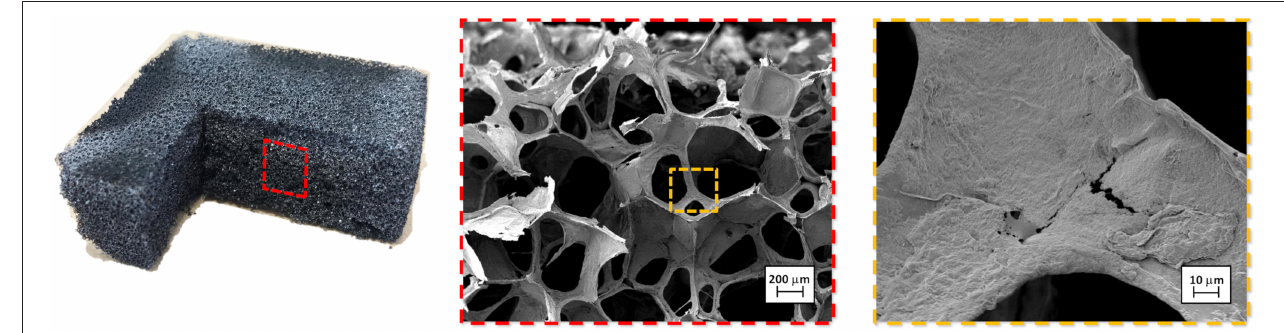
FIGURE 6 | SEM analysis (50X and 1000X) performed on the residue PU-3L collected after cone calorimetry test.